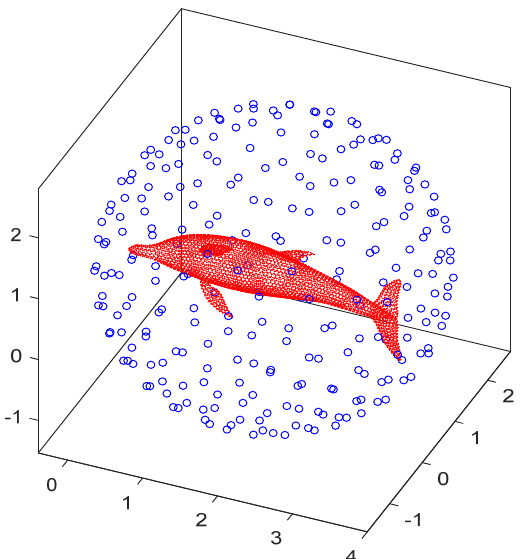
Figure 8. Geometry of the problem and the distribution of the shifted Gauss–Lobatto nodes.